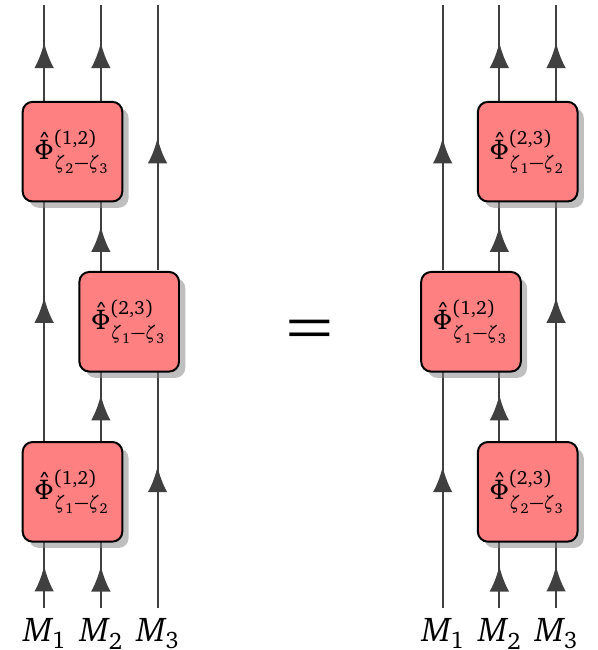
Figure 4: Schematic representation of a set-theoretic (functional) Yang–Baxter equa- tion in the braid form, representing an intertwining property of three consecutive applications of the Yang–Baxter map on a product phase space M